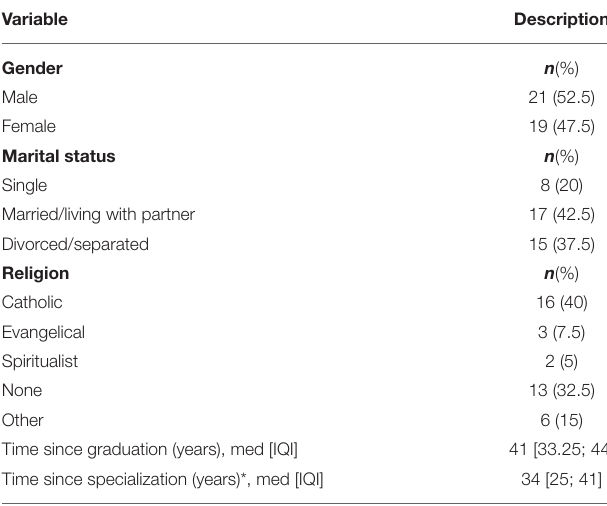
TABLE 1 | Sociodemographic characteristics of the 40